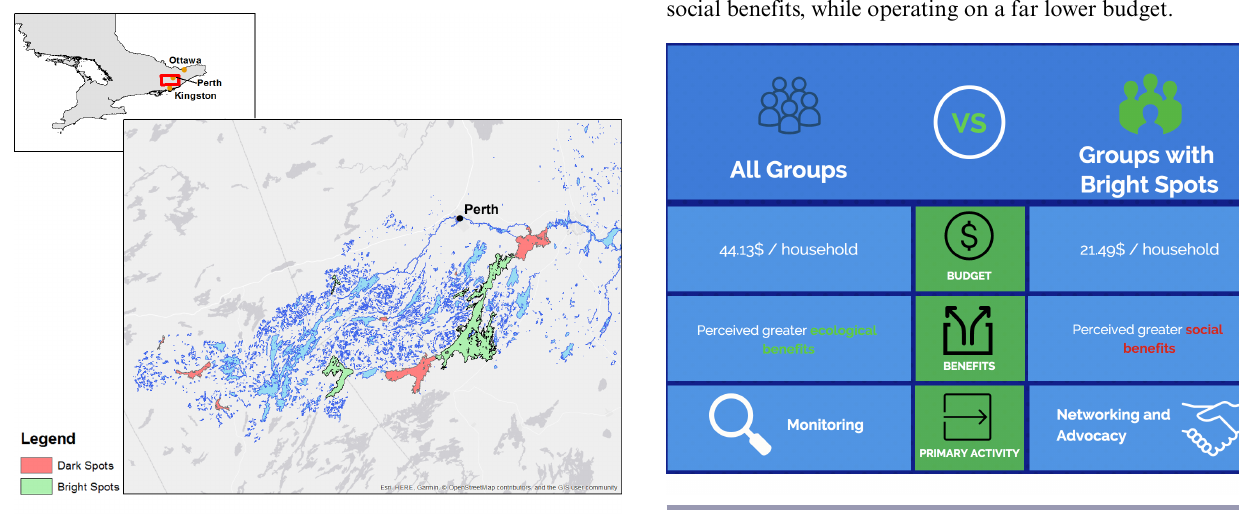
Fig. 6 . A comparison of three key characteristic